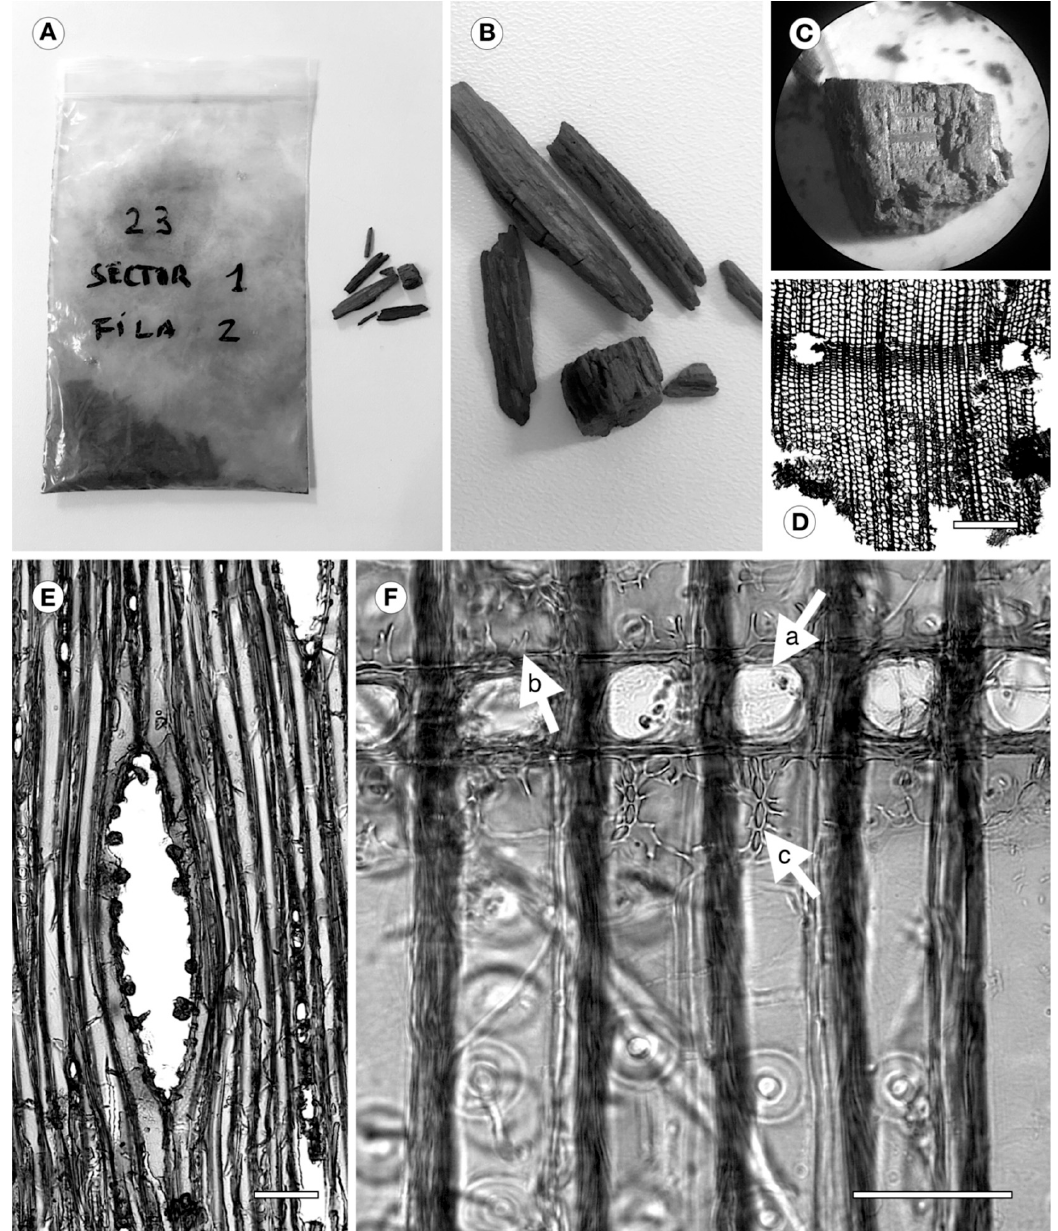
Figure 1. A , B , C , Samples from the coffin. D , Transverse section—Distinct growth rings with abrupt transition and axial resin canals with thin-walled epithelial cells. E , Tangential section—Multiseriate ray formerly containing a radial resin canal. F , Heterogeneous ray—a, window-like cross-field pit, b, dentate ray tracheids, c, tracheid pits in end walls of ray tracheids. Scale bars—D, 400 μ m; E, 150 μ m; F, 50 μ m.